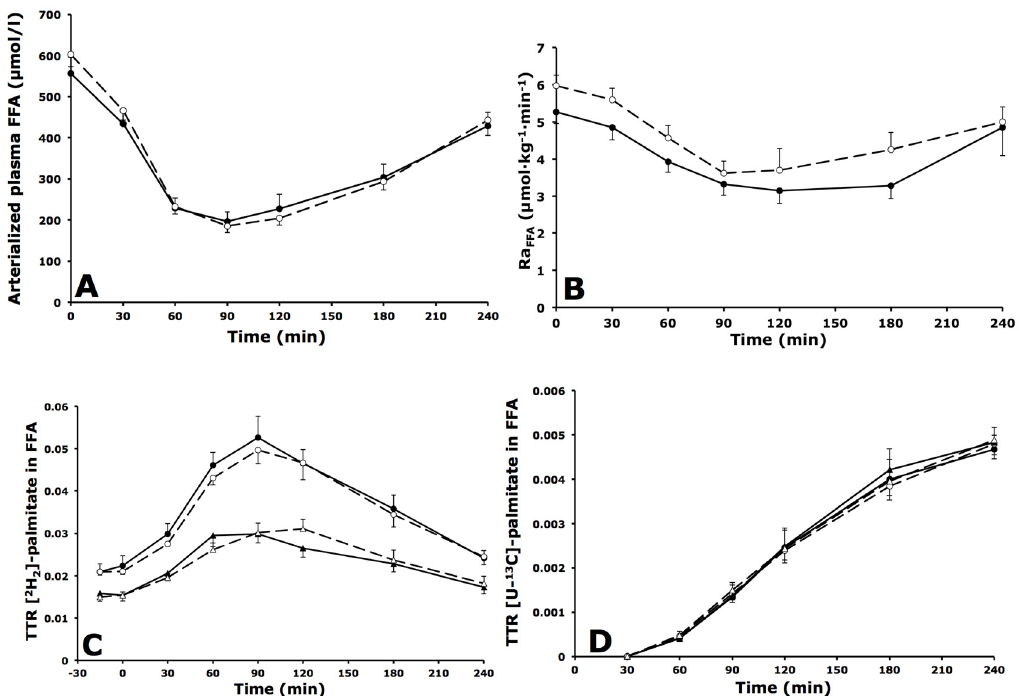
Figure 2. Fasting and postprandial whole body free fatty acid (FFA) metabolism. ( A ) Arterialized plasma FFA concentrations; ( B ) Rate of appearance (Ra) of FFA; ( C ) TTR [ 2 H 2 ]-palmitate concentrations in FFA during fasting ( t = 0) and after consumption of a high-fat mixed-meal; ( D ) TTR [U- 13 C]-palmitate after consumption of a high-fat mixed-meal in IFG (black symbols, solid lines) and IGT subjects (open symbols, dashed lines). Circles represent arterialized plasma concentrations; triangles represent venous plasma concentrations. Values are mean ± SEM.